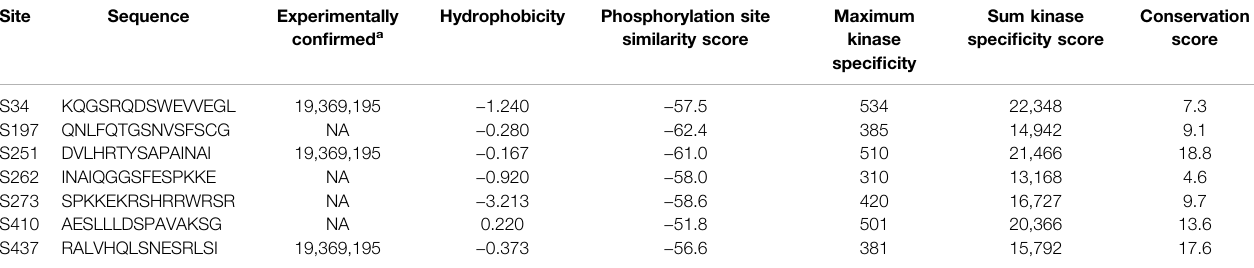
TABLE 1 | Analysis of CPTAC-identi fi ed phosphorylation sites of OSBPL3 via the PhosphoNET database. Site Sequence Experimentally con fi rmed a